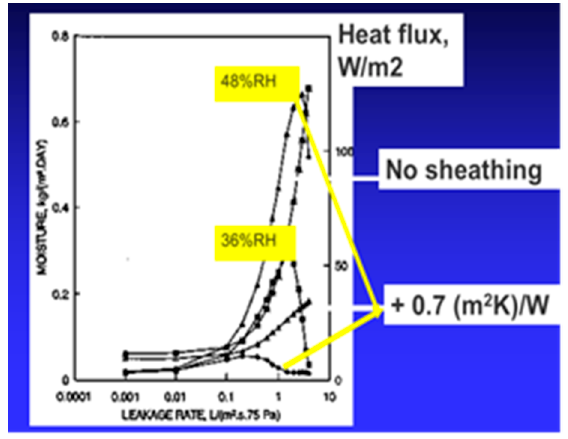
Figure 4. Effect of a thermal insulating sheathing compared with the case of cellulose fiber insulation discussed in stage 1 (from author archive).